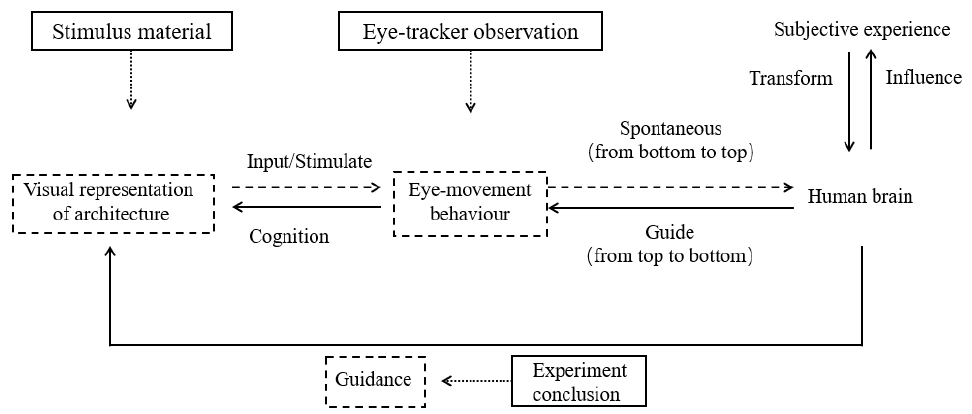
Figure 1. Experimental schematic diagram.